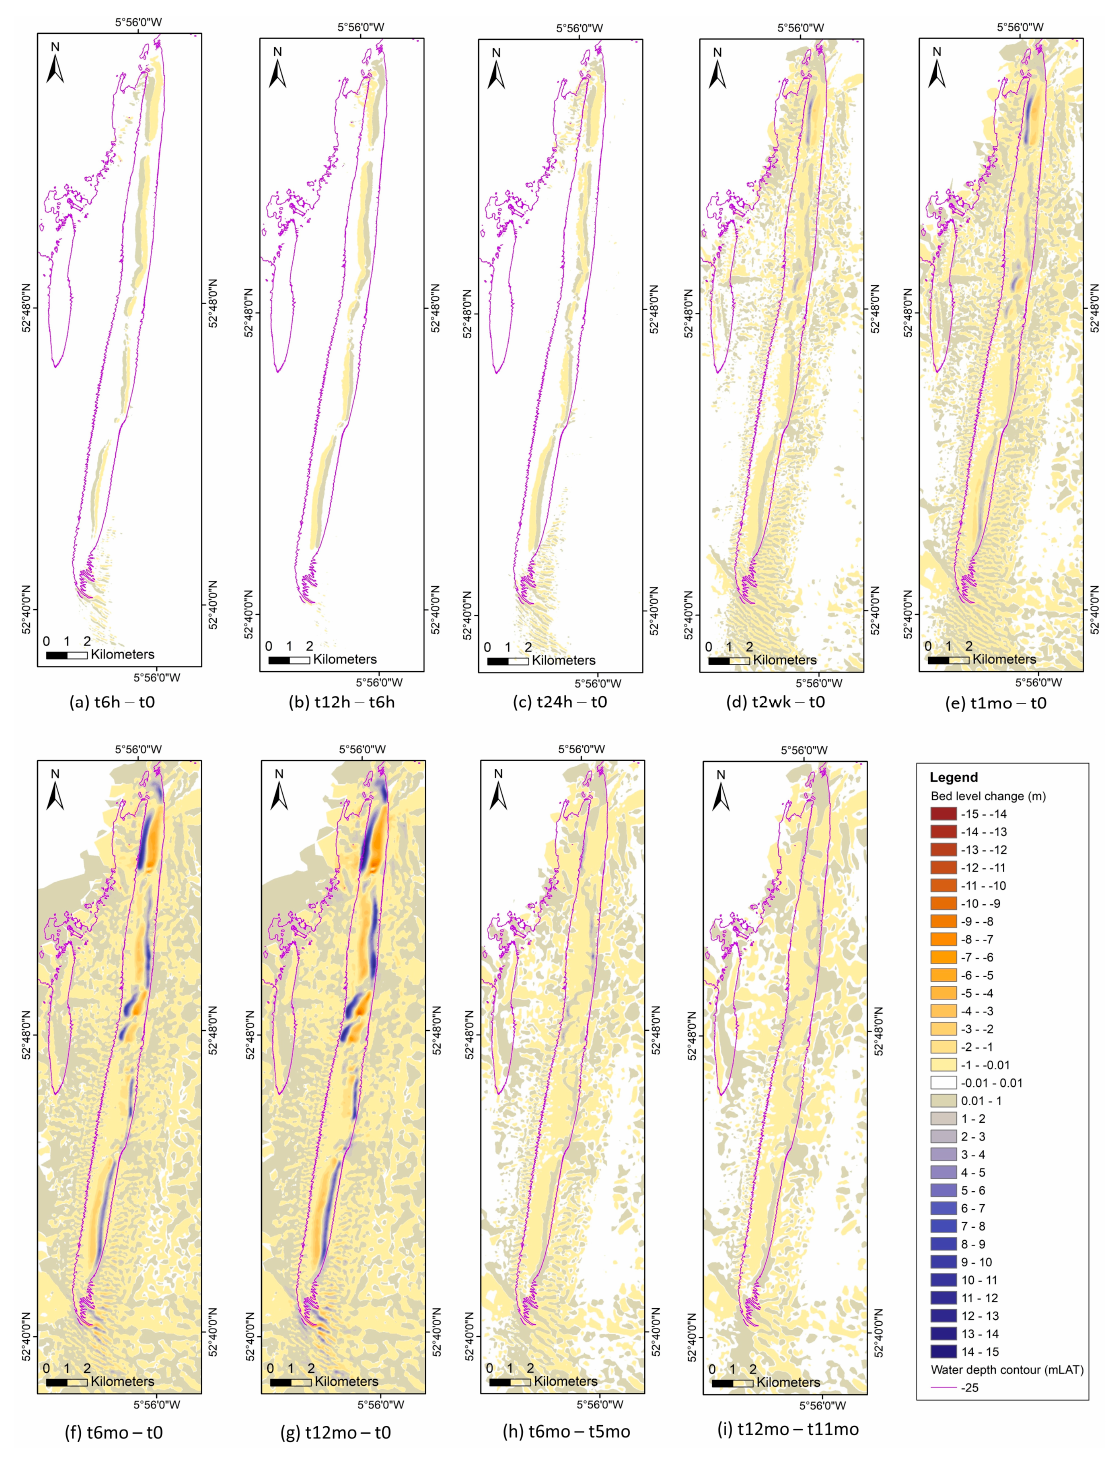
Figure 3. Bed level changes at Arklow Bank over various time periods calculated from extracted simulated bed levels; ( a ) after one ebb tidal phase, ( b ) after one flood tidal phase, ( c ) after two ebb and two flood tides, ( d ) after one spring-neap cycle, ( e – g ) after 1, 6 and 12 lunar month simulations, ( h – i ) after one spring-neap cycle between simulation months 5 and 6, and 11 and 12, respectively. A − 25 m water depth contour is provided based on INFOMAR bathymetry data referenced to Lowest Astronomical Tide (LAT). INFOMAR data available at: https://www.infomar.ie/, (accessed